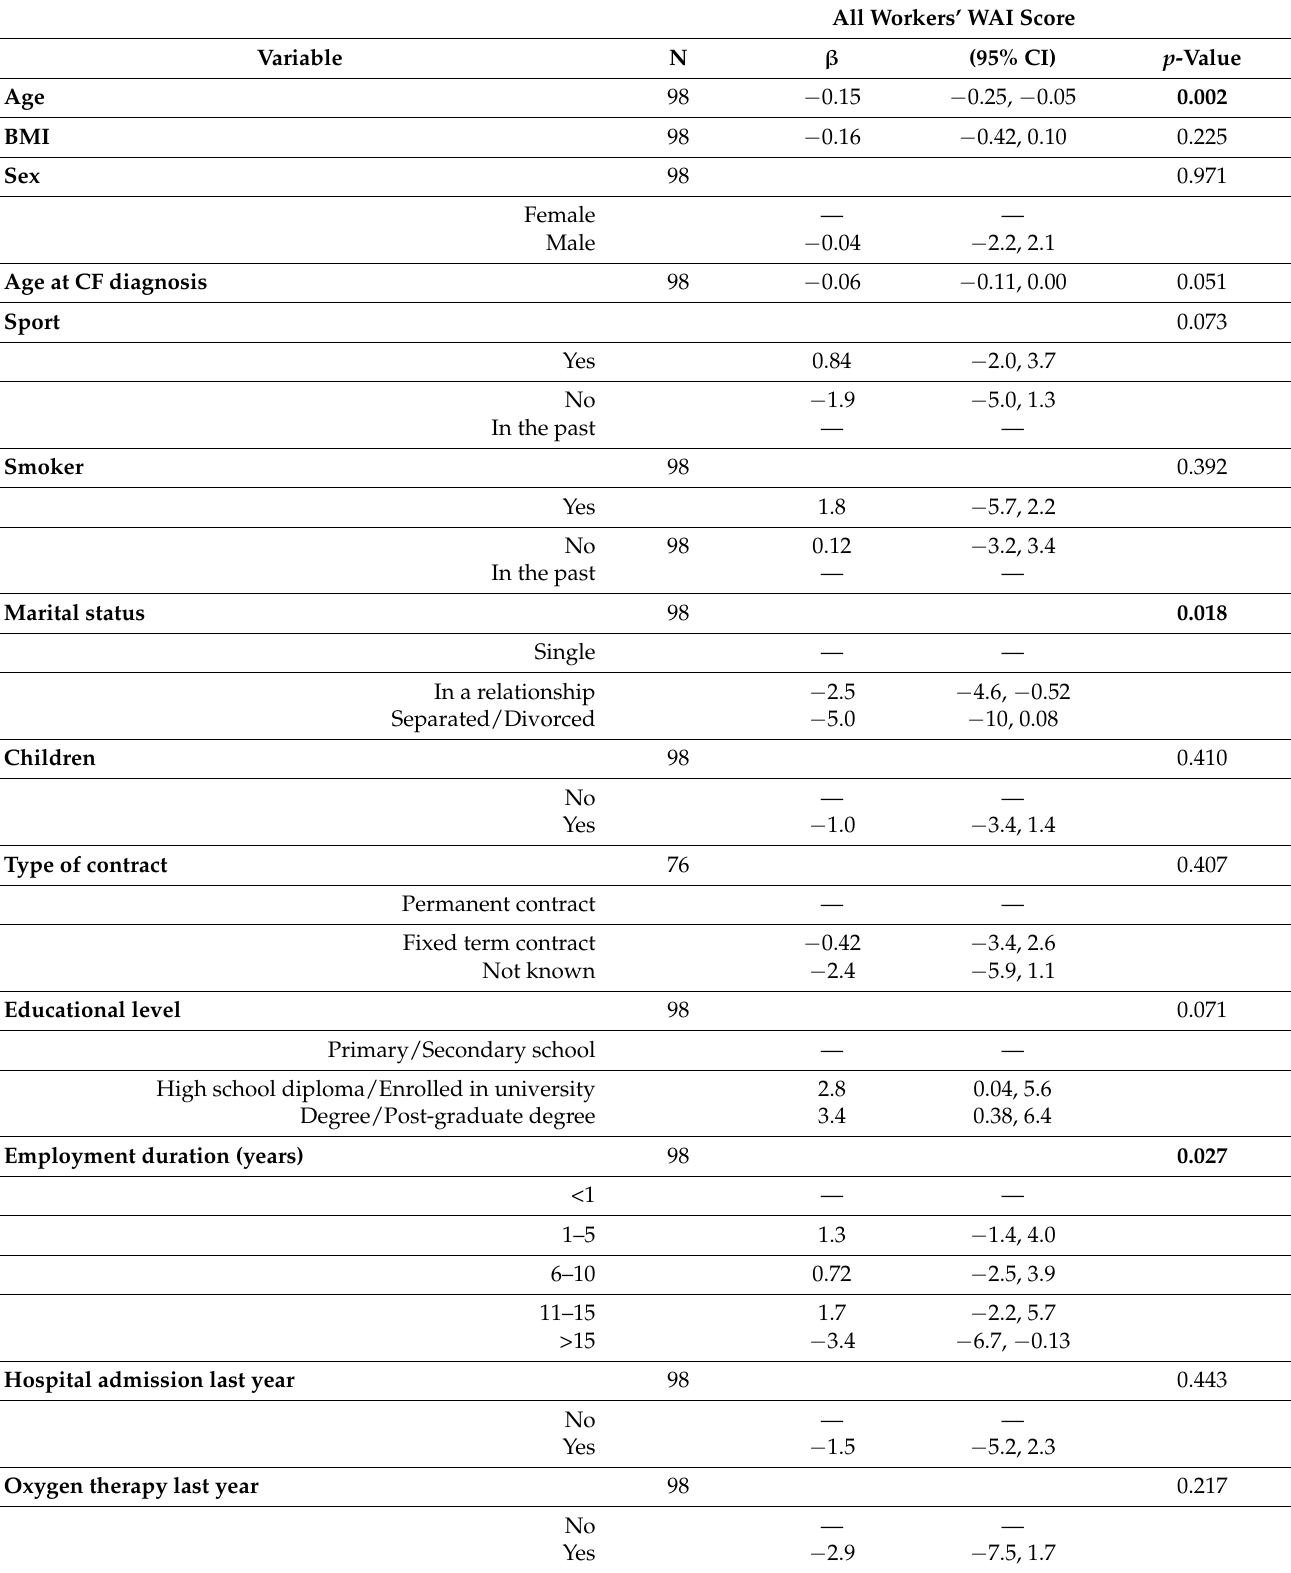
Table 4. Possible predictive factors for changes in work ability. Significant values are marked in